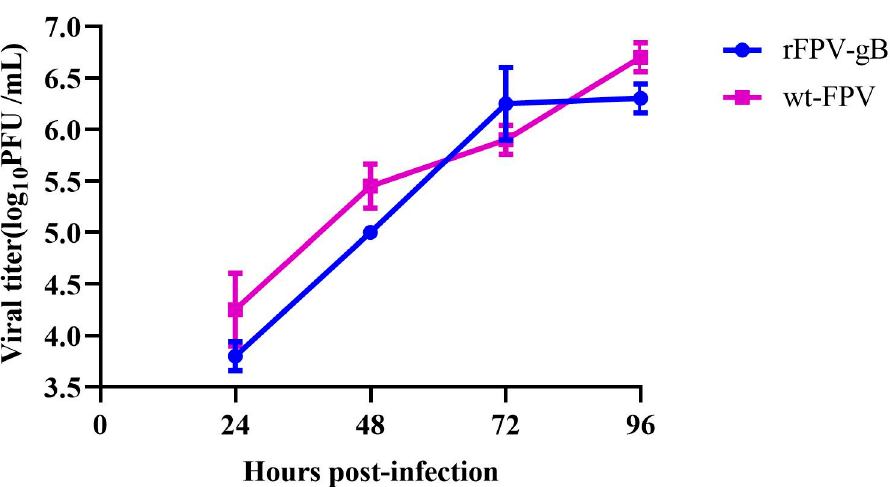
Figure 4. Growth kinetics of recombinants in CEF cells. CEF cells were infected with rFPV-gB or wt-FPV at a multiple of infection (MOI) of 0.02. After 1 h of fowlpox virus adsorption, cells were washed twice with PBS to remove unbound virus particles and DMEM medium containing 1% FBS was added. The infected cells were harvested by three freeze/thaw cycles at different time-points and PFUs of FPVs were determined.